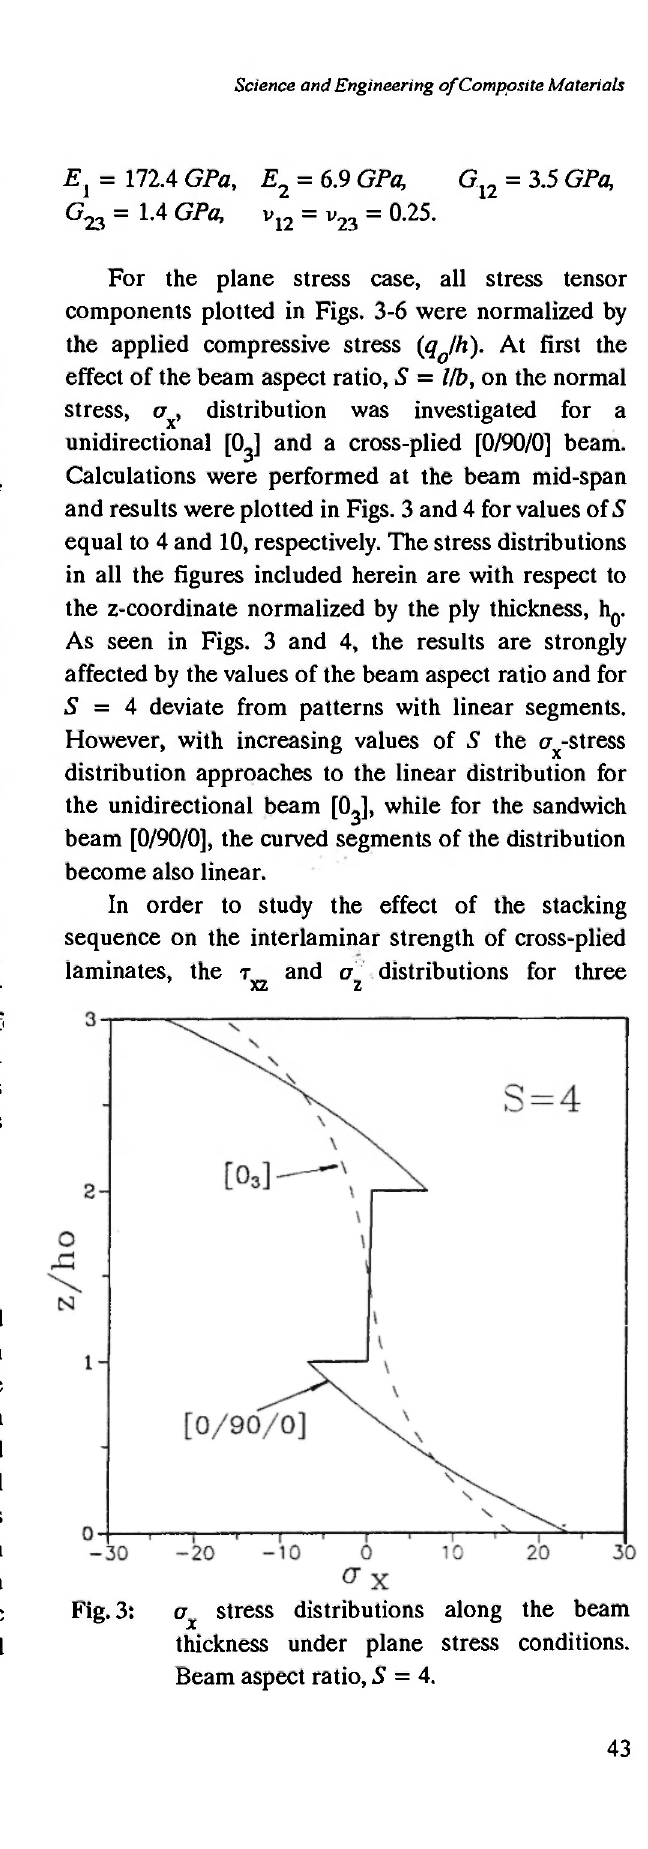
Fig. 3: σ χ stress distributions along the beam thickness under plane stress conditions. Beam aspect ratio, 5 =